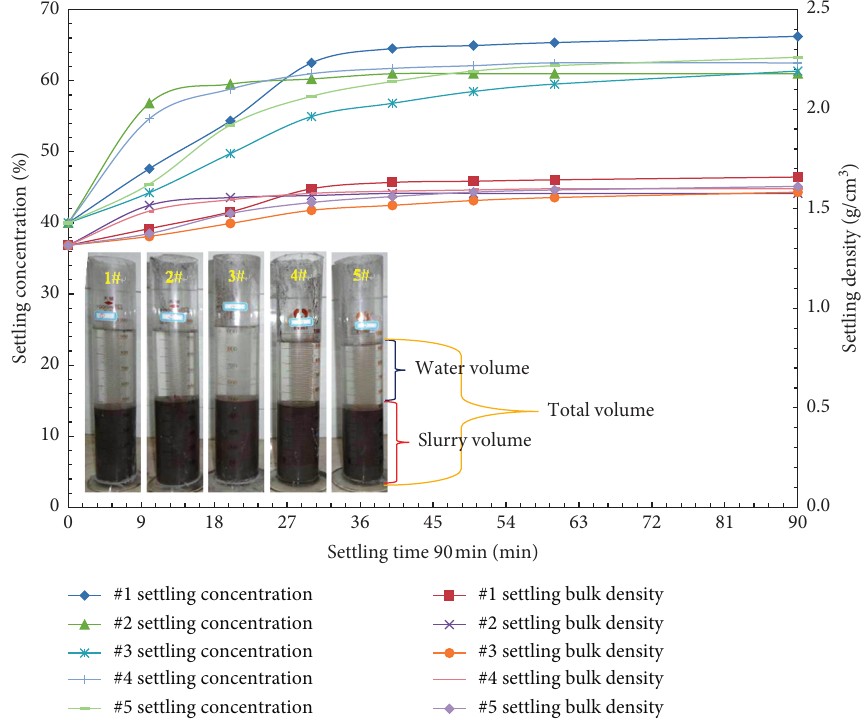
Figure 15: Curves of settling concentration and bulk density (90min).